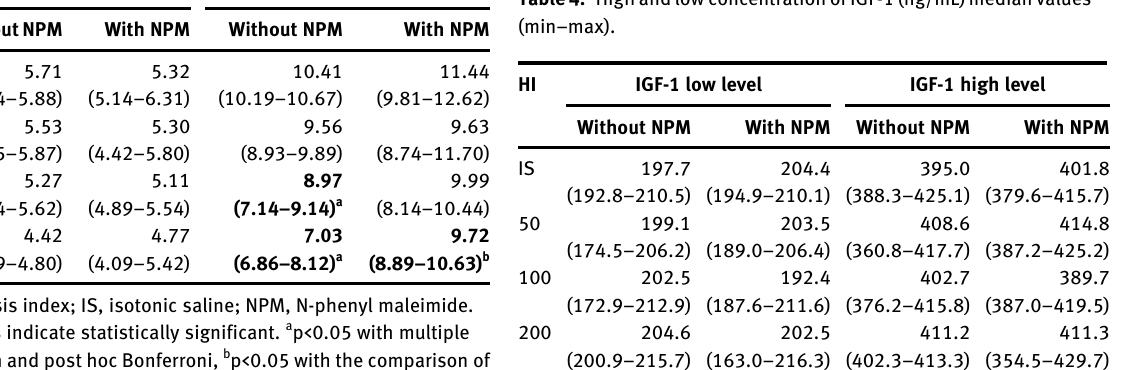
Table  : HighandlowconcentrationofIGF-  (ng/mL)medianvalues